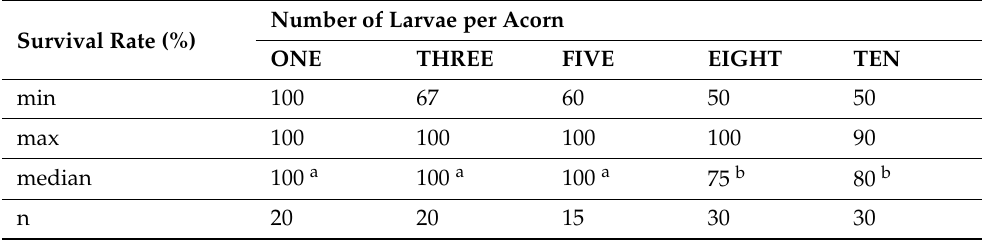
Table 1. Larval survival rates at different population